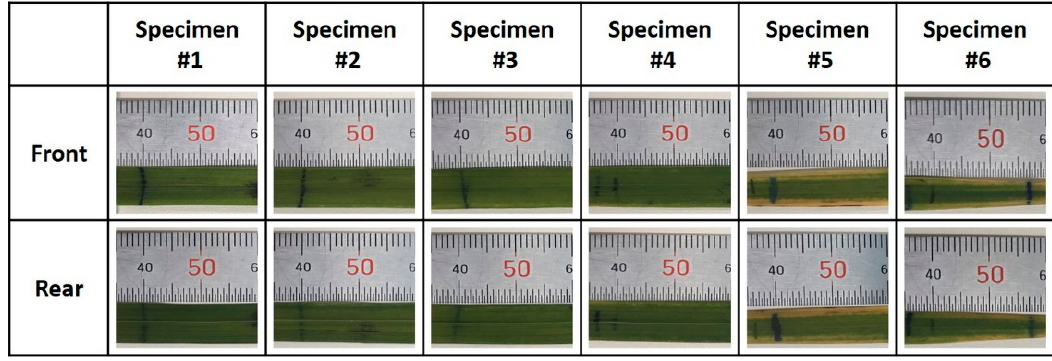
Figure 3. Photographs for six rice leaf specimens.